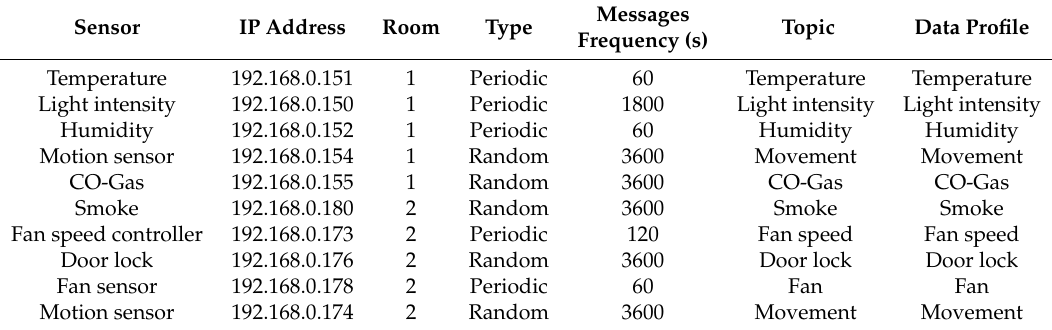
Table 2. IoT sensors adopted in the MQTTset